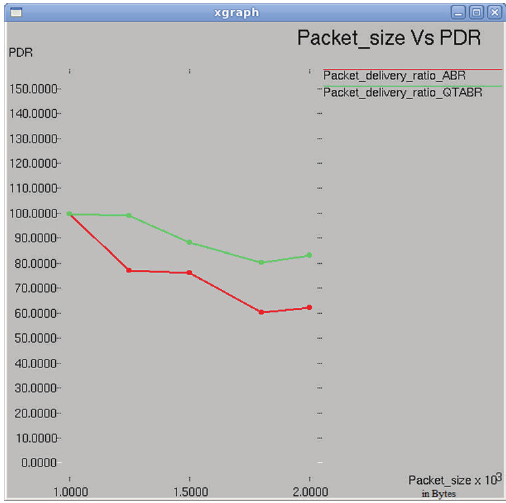
Figure 7: Nodes versus PDR.